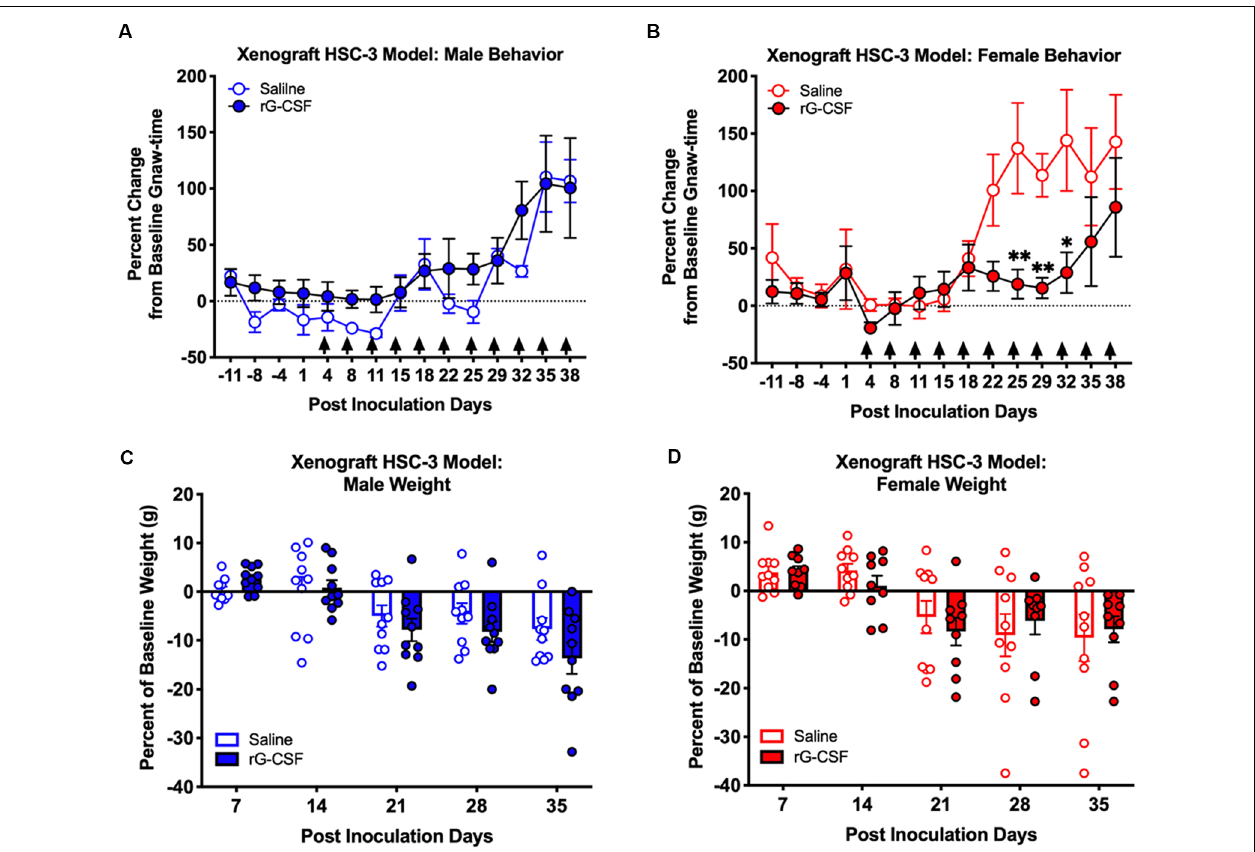
FIGURE 4 | HSC-3 xenograft-induced change in orofacial nociceptive behavior was measured in adult nude male (A) and female (B) mice receiving saline ( N = 10, open circles) or rG-CSF treatment (2.5 µ g/mouse, N = 10, closed circles) 24 h prior to each dolognawmeter measurement, as indicated by the black arrows. Sexes were independently analyzed. Two-way ANOVA, ∗ P < 0.05, ∗∗ P < 0.01. HSC-3 xenograft-induced weight loss was measured in male (C) and female (D) mice receiving saline ( N = 10, open bars) or rG-CSF (2.5 µ g/mouse, N = 10, closed bars) each week.